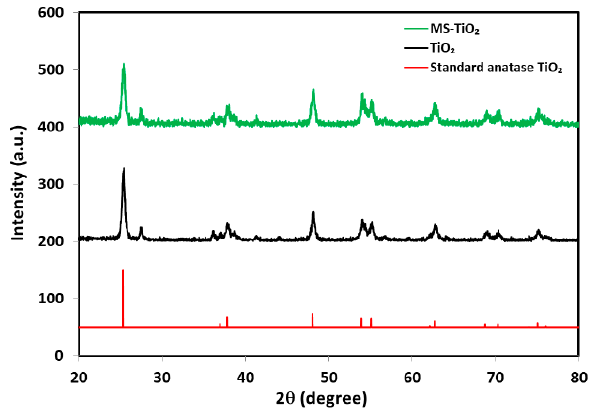
Figure 1. XRD plot of TiO 2 (aeroxide), MS-TiO 2 , and standard anatase TiO 2.